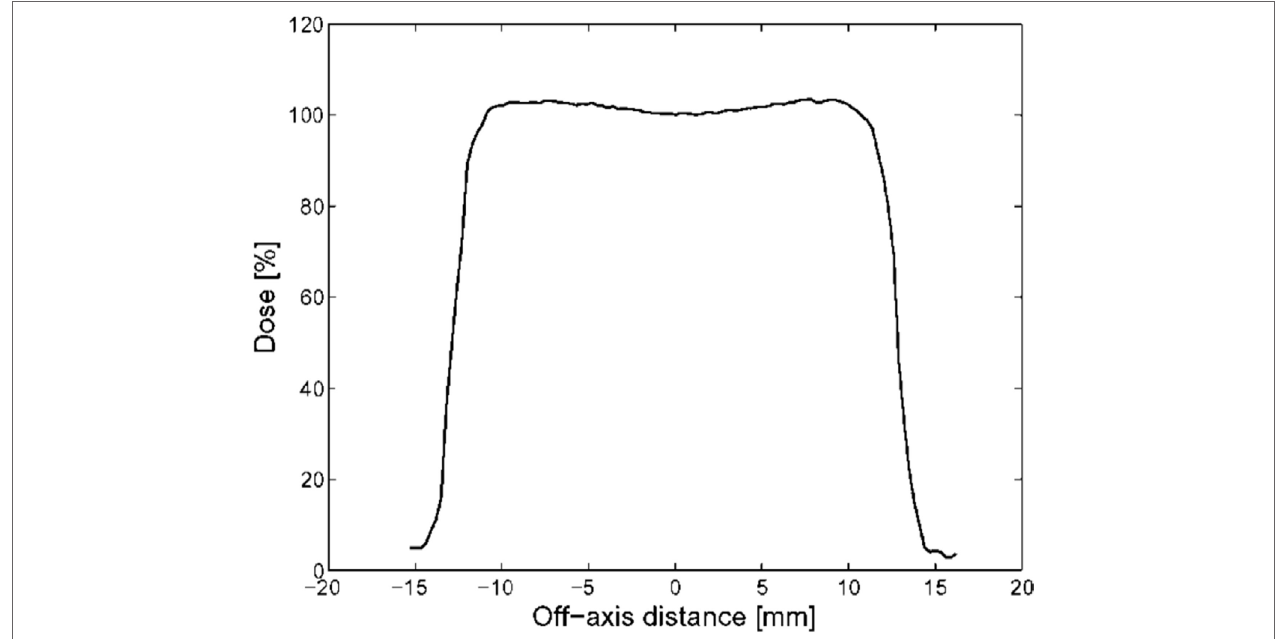
FIgURe 2 | Experimental lateral dose distribution acquired with a silicon diode. This picture reproduced with the permission of the